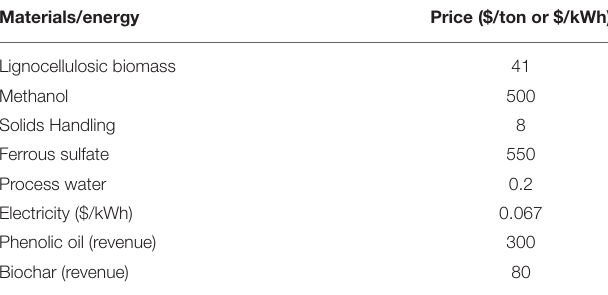
TABLE 4 | Material/Energy costs and revenues earned for a 250 ton/day ATP biorefinery facility producing sugar, phenolic oil, and biochar.